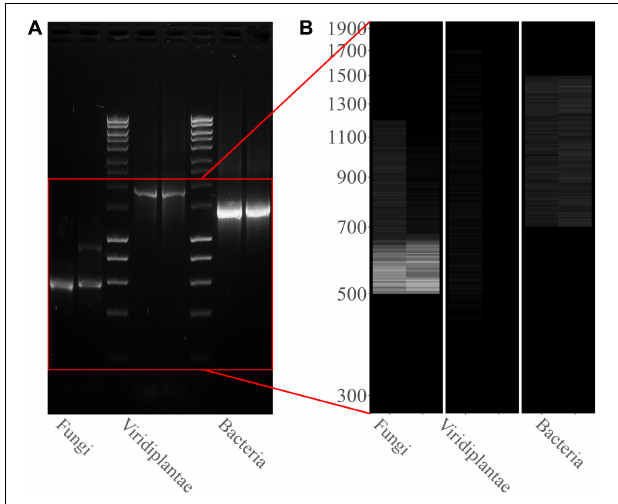
FIGURE 1 | Kingdom rDNA-specific PCR amplicon agarose gel and virtual gel: (A) Electrophoretic gel (agarose 1%) shows three separate and different PCR runs for both samples analyzed: ITS1-4 for fungi, 18S EUK-a/b for Viridiplantae, and 16S for bacteria. Bioline HyperLadderTM 1 kb was used. (B) Virtual gel showing the distribution of the reads per kingdom. Samples in the both images are ordered as follows: Sample 1 and Sample 2.